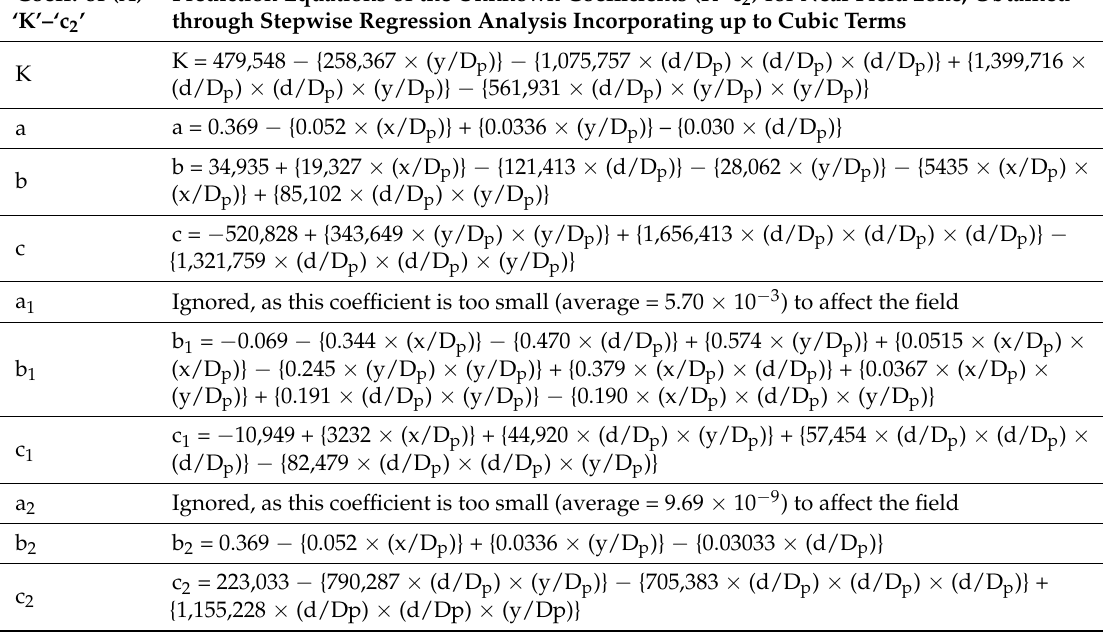
Table 4. Regression equations for predicting K, a, b, c, a 1 , b 1 , c 1 , a 2 , b 2 and c 2 for Near Field . Coeff. of (A) Prediction Equations of the Unknown Coefficients (K~c 2 ) for Near Field zone, ‘K’–‘c 2 ’